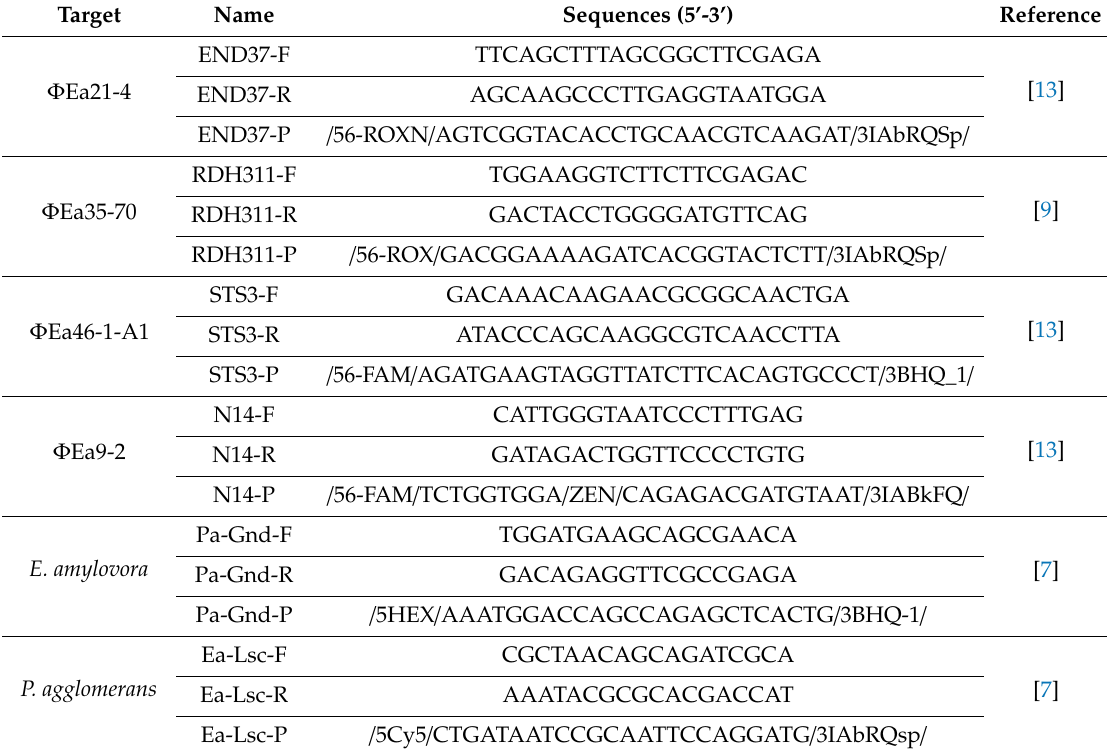
Table 3. Primers and probes used for molecular quantification of phage and